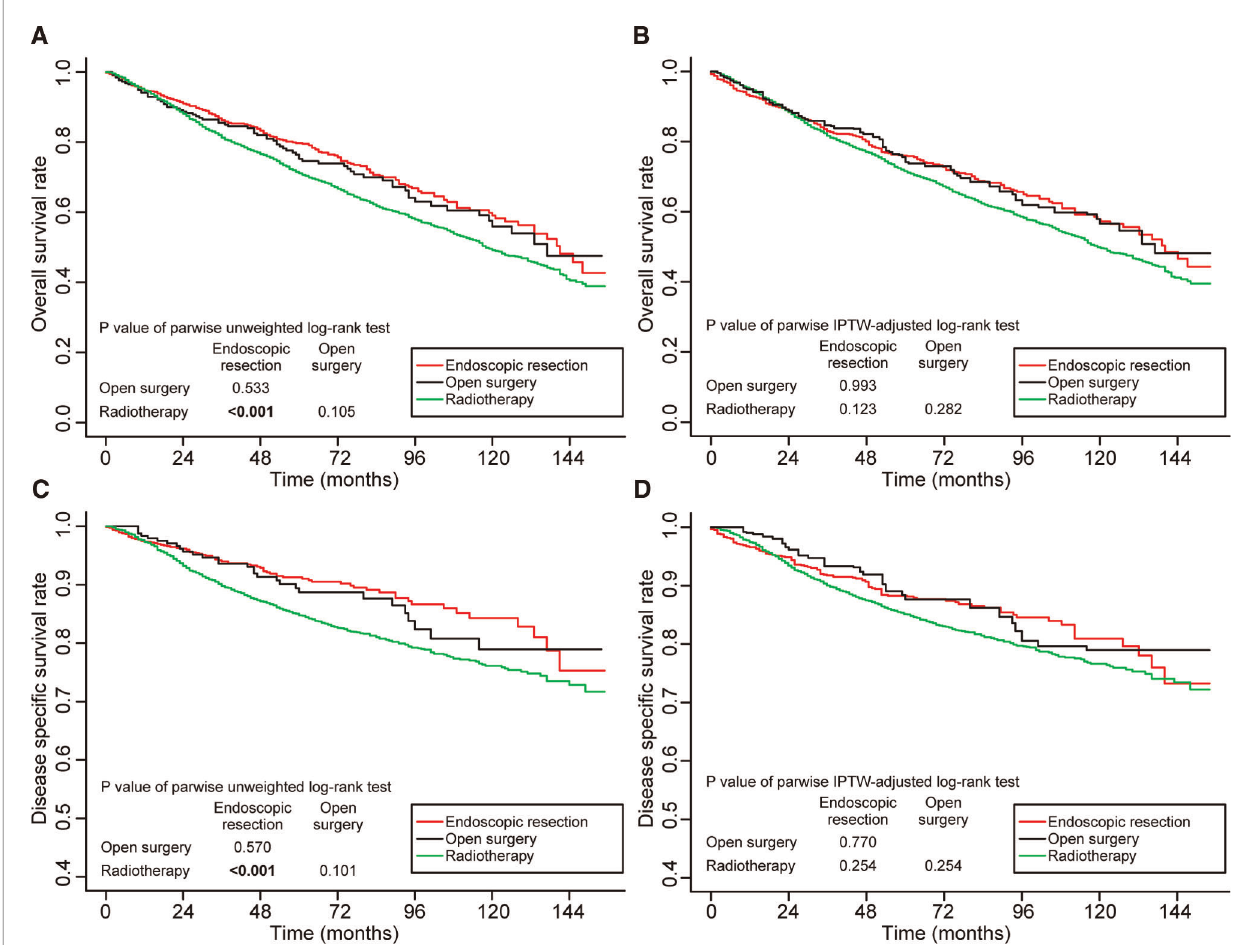
FIGURE 2 | Kaplan – Meier curves for overall survival ( A,B ) and disease-speci fi c survival ( C,D ) before and after weighting in the whole cohort. Signi fi cant p values are in bold font. IPTW, inverse probability of treatment